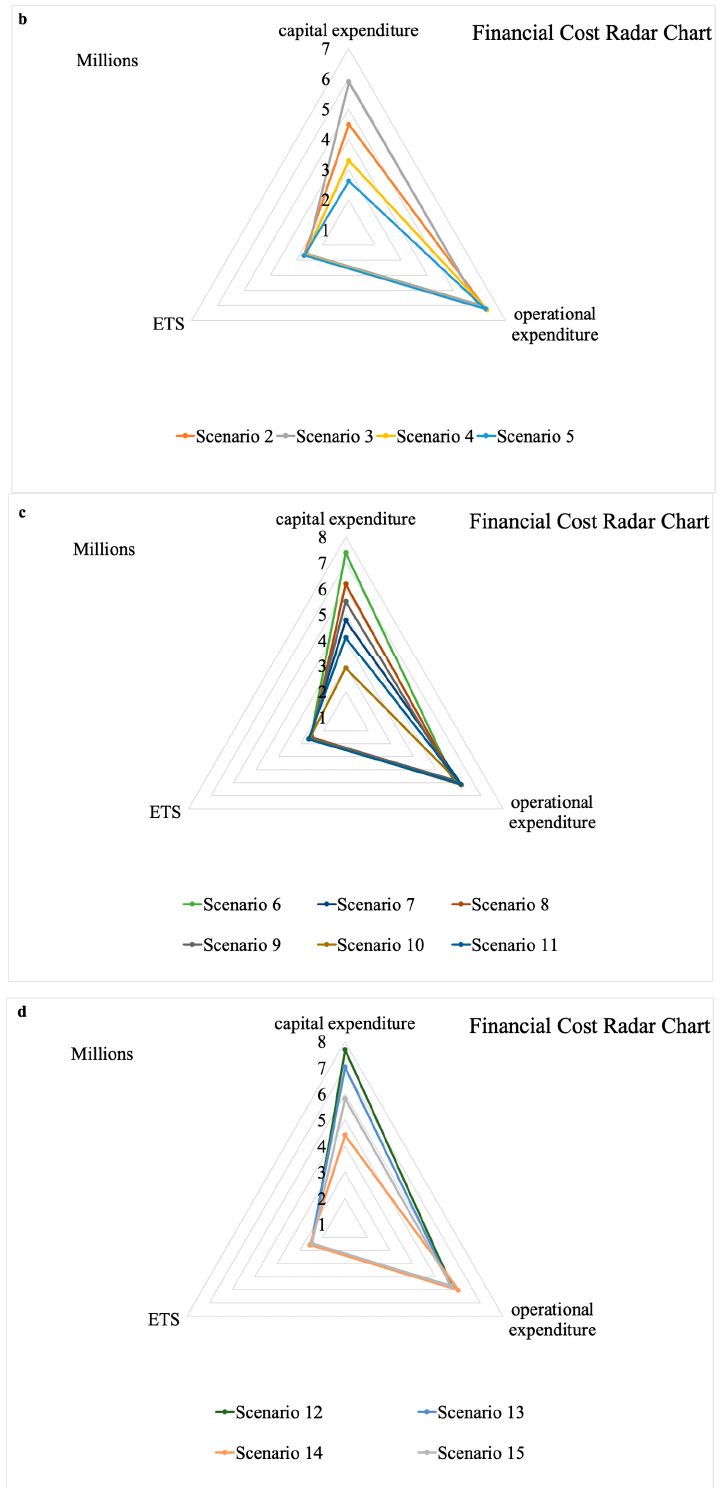
Figure 4. Radar charts for the absolute value of capital expenditure, operational expenditure, and cost of the emission trade system, with ( a ) scenarios either using only digital tools (Scenario 1) or only energy efficient approaches (Scenario 16); ( b ) scenarios using digital tools in three out of the four cases and energy efficient equipment in the fourth (Scenarios 2, 3, 4 and 5); ( c ) scenarios equally implementing digital and energy efficient solutions (Scenarios 6, 7, 8, 9, 10 and 11); ( d ) scenarios where energy efficient equipment is the dominant approach (Scenarios 12, 13, 14 and 15).